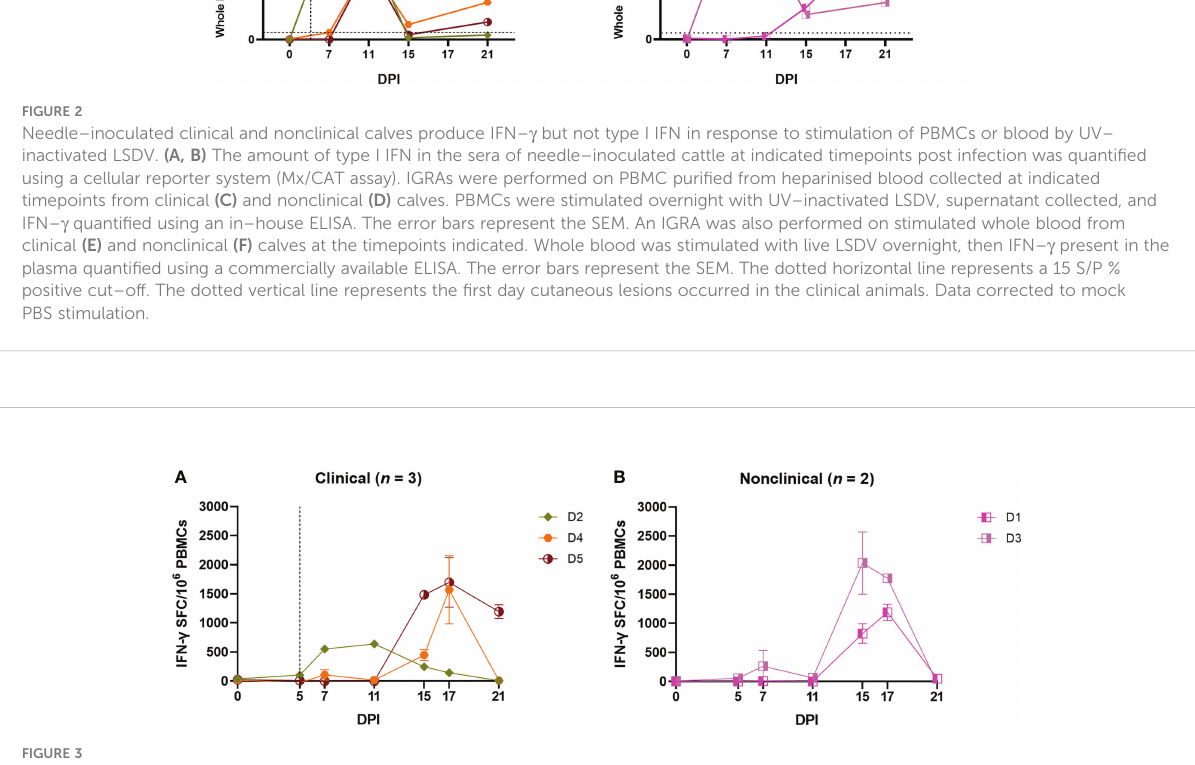
FIGURE 3 Needle – inoculated clinical (A) and nonclinical (B) calves produce IFN – g in response to stimulation of PBMCs by UV – inactivated LSDV as measured by ELISpot assay. The number of IFN – g producing PBMCs stimulated with SW – UV inactivated LSDV was determined by IFN – g ELISpot and presented as spot forming cells/million (SFC/10 6 ). The error bars represent the SEM. The dotted line represents the fi rst day of the onset of cutaneous lesions in the clinical animals. Data corrected to mock PBS stimulation.